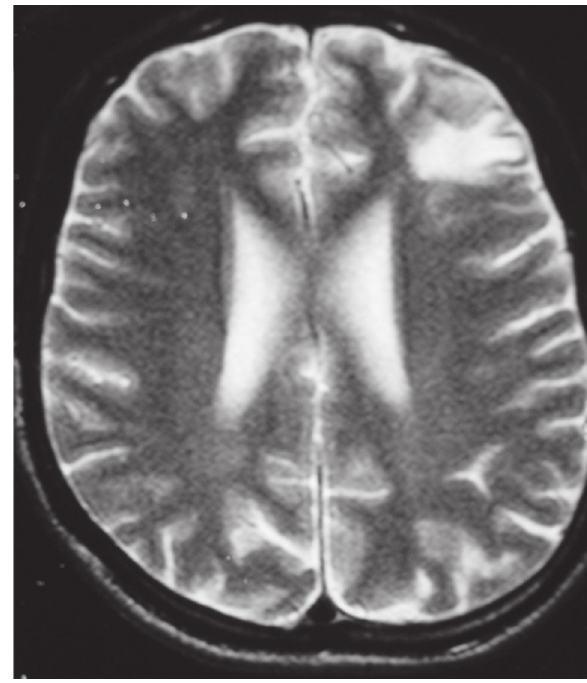
Figure 5. Case 5 – RM (T2 axial) showing a subcortical white matter lesion in the right frontal